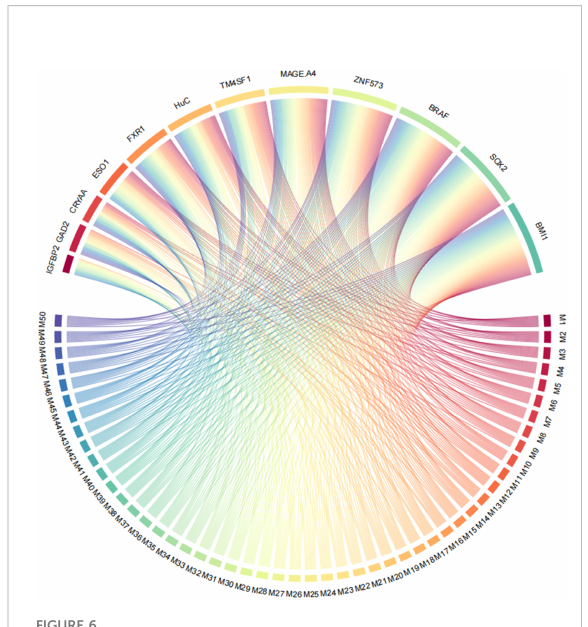
FIGURE 6 Use of ZNF573, BRAF, TM4SF1, SOX2, IGFBP2, MAGE.A4, BMI1,